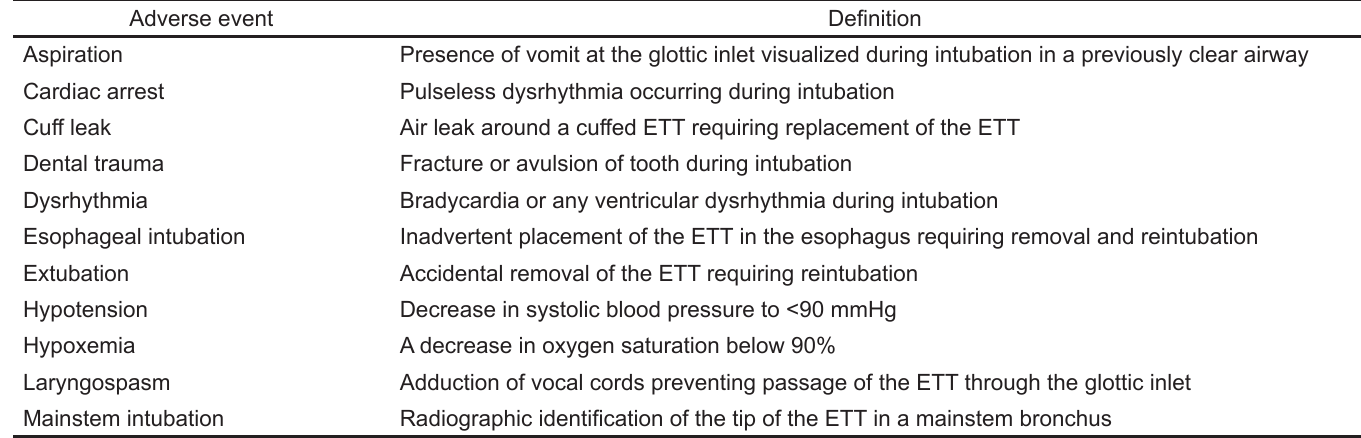
Table 1. Definitions of adverse